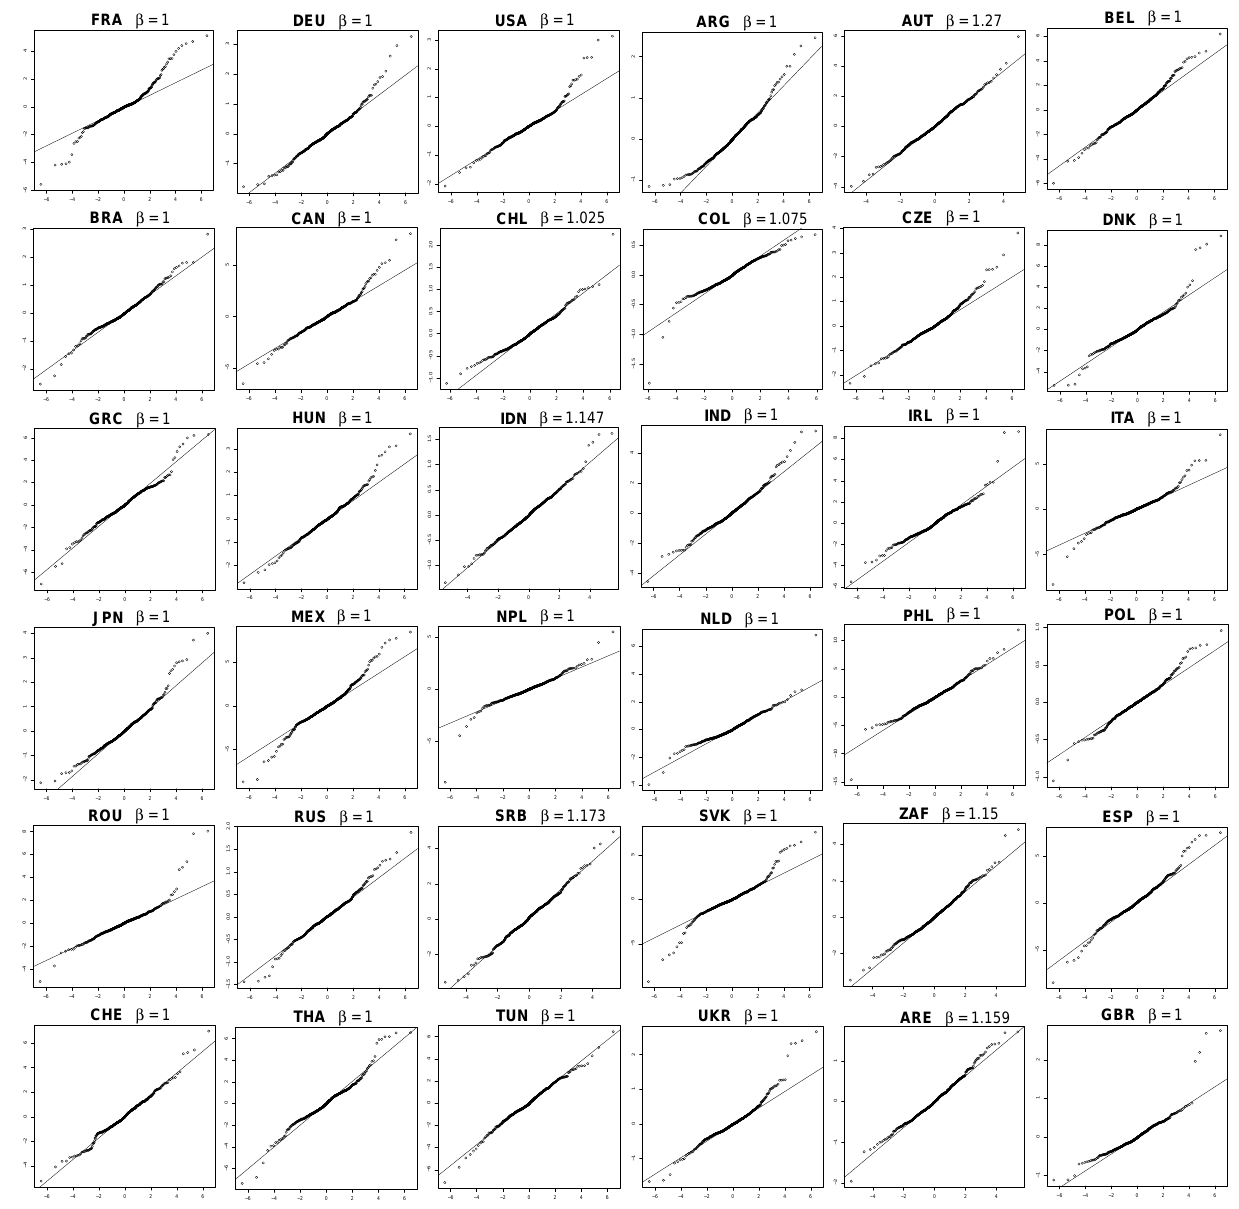
Figure A6. Quantile-quantile plot with 36 countries comparing ε t (without using the festive day correction) with the optimal exponential distribution using the R-package normalp . In the horizontal axis we show the theoretical quantiles and in the vertical axis, the sample quantiles. Note that the exponential distribution shape parameter β , indicated on the graphs can have values